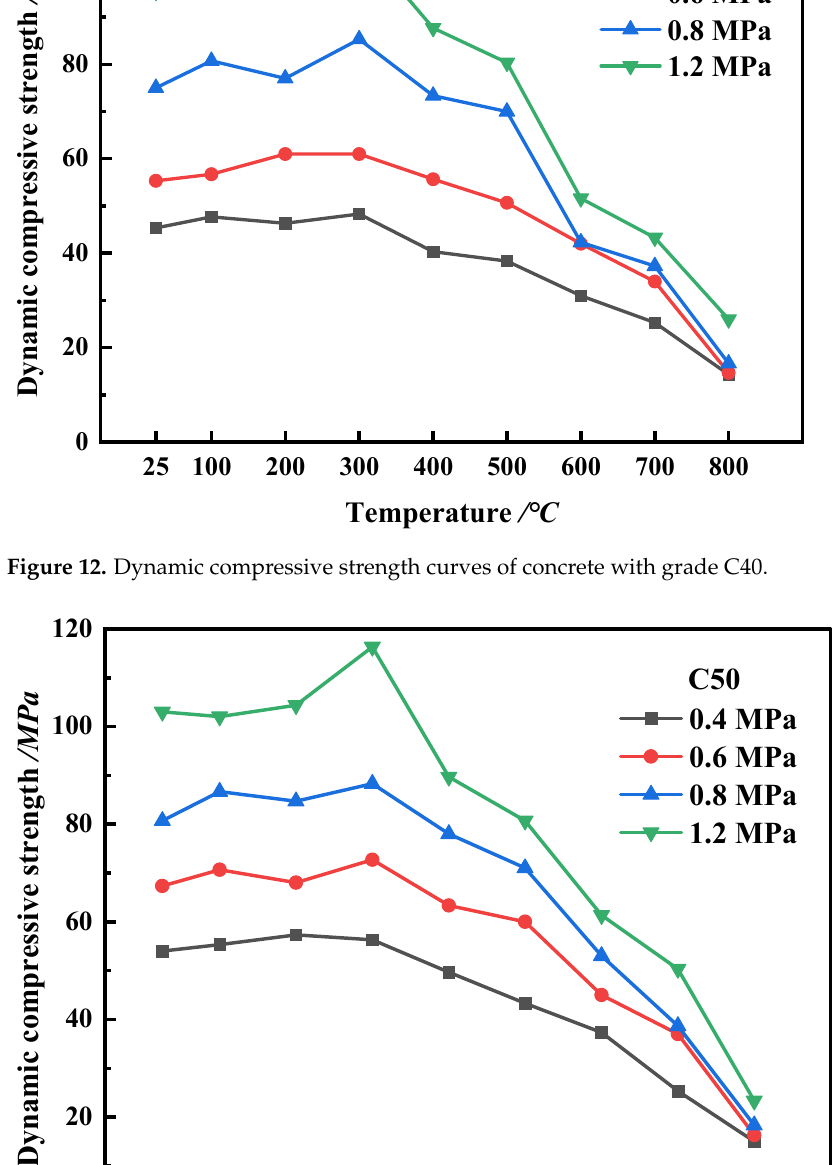
Figure 11. Dynamic compressive strength curves of concrete with grade C30.